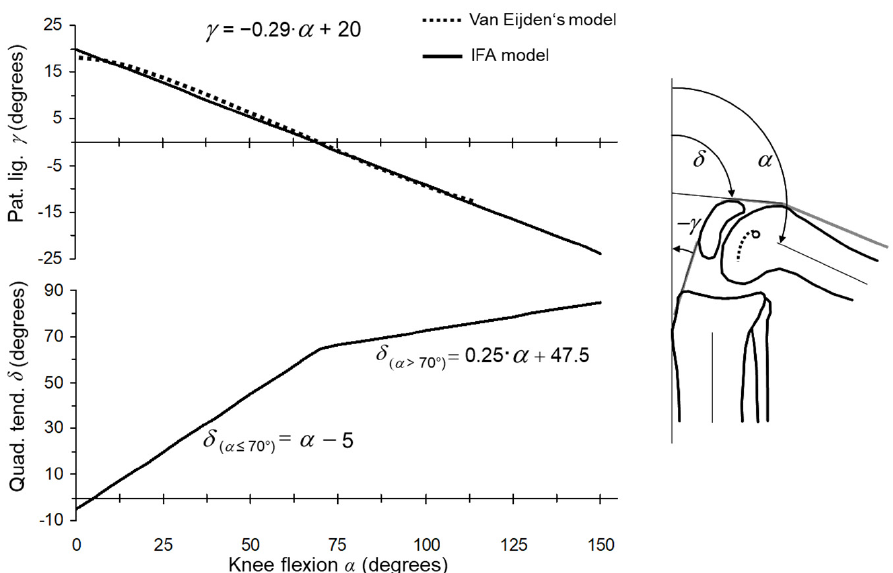
Figure 3. Angles of the patellar ligament and quadriceps tendon with respect to knee flexion angle. The angles of the patellar ligament from the model of Eijden van et al. [27] are depicted for comparison purposes.